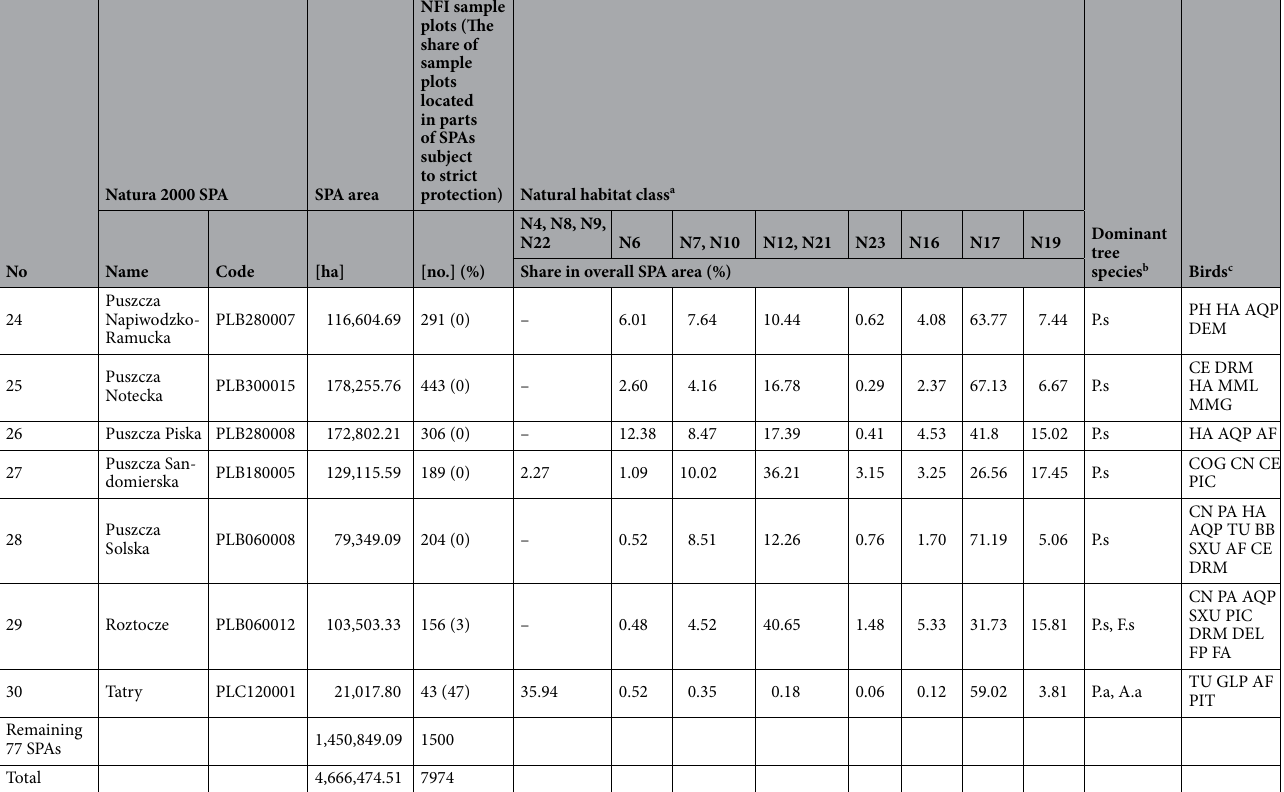
4,666,474.51 Table 1. Shares of natural habitat classes in the 30 selected Special Protection Areas. a According to the Standard Data Form 50 : N4—sand beaches; N6—inland water bodies (standing water, running water); N7— bogs, marshes, water fringed vegetation, fens; N8—heath, scrub, maquis and garrigue, phrygana; N9—dry grassland, steppes; N10—humid grassland, mesophile grassland; N12—extensive cereal cultures (including rotation cultures with regular fallowing); N16—broad-leaved deciduous woodland; N17—coniferous woodland; N19—mixed woodland; N21—non-forest areas cultivated with woody plants (including orchards, groves, vineyards, dehesas); N22—inland rocks, screes, N23—other land (including towns, villages, roads, waste places, mines, industrial sites); b Tree species with a share of > 10% in overall stand volume (in